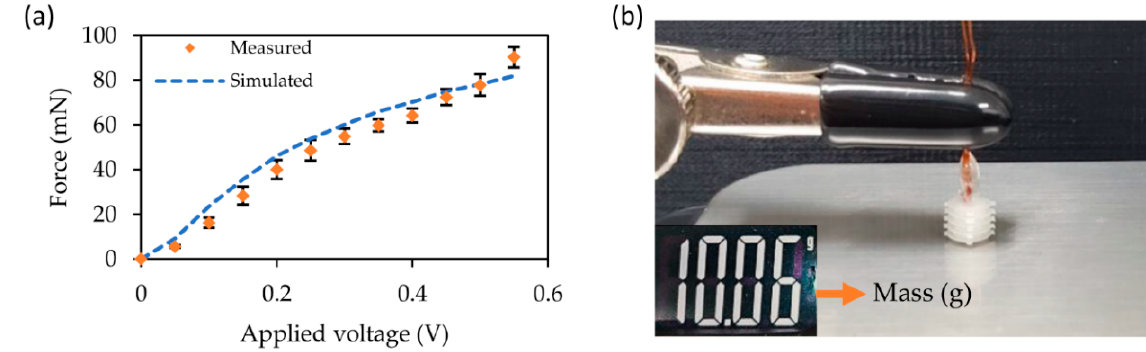
Figure 6. Steady-state force characteristics. ( a ) Experimental data (dot) and model prediction (solid line) of the thermopneumatic actuator, voltage was applied up to the maximum operating voltage of 0.55 V, and the force was measured at 0.05 V intervals. ( b ) Measuring the vertical force applied during expansion when 0.55 V, the maximum operating voltage of the thermopneumatic actuator, is applied. Inset shows measured mass in gram.